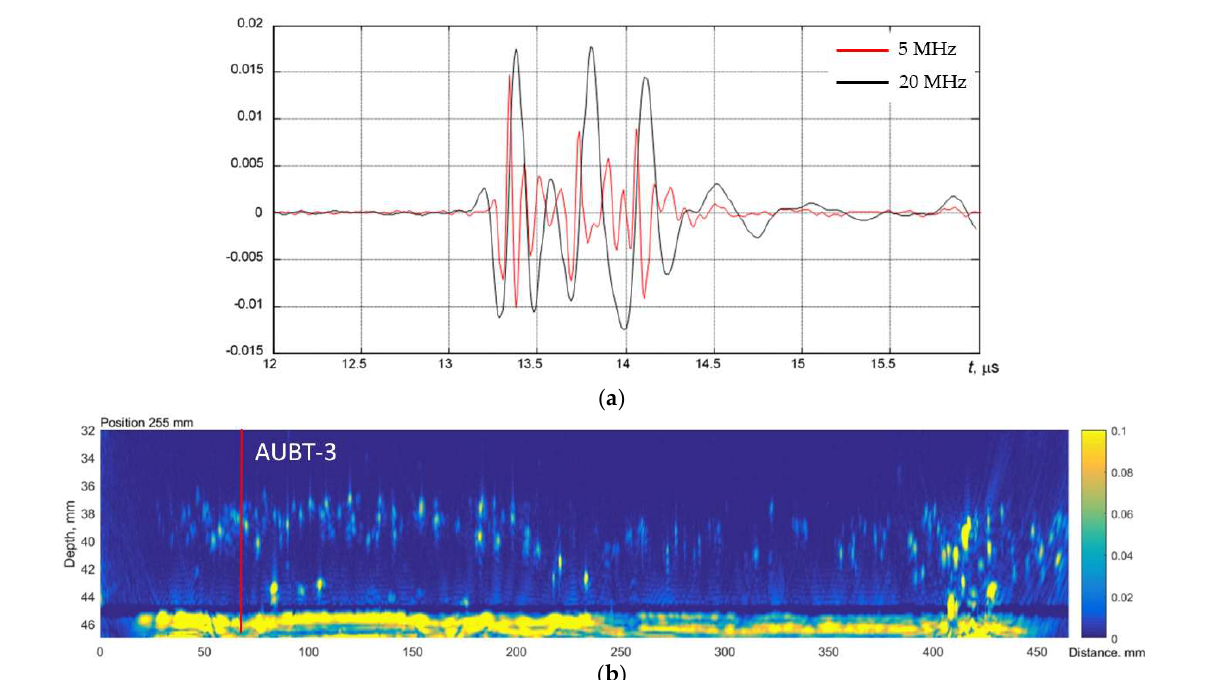
Figure 10. ( a ) The waveforms of the received signals at the point AUBT-3 with 5 MHz (black) and 20 MHz (red) transducers and ( b ) the corresponding TFM image, showing appropriate AUBT measurement location. Vertical colour bar represents the peak-to-peak amplitude in arbitrary units.